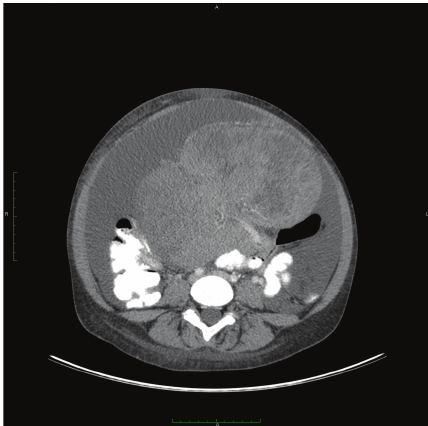
Figure 1: Germ cell tumor.